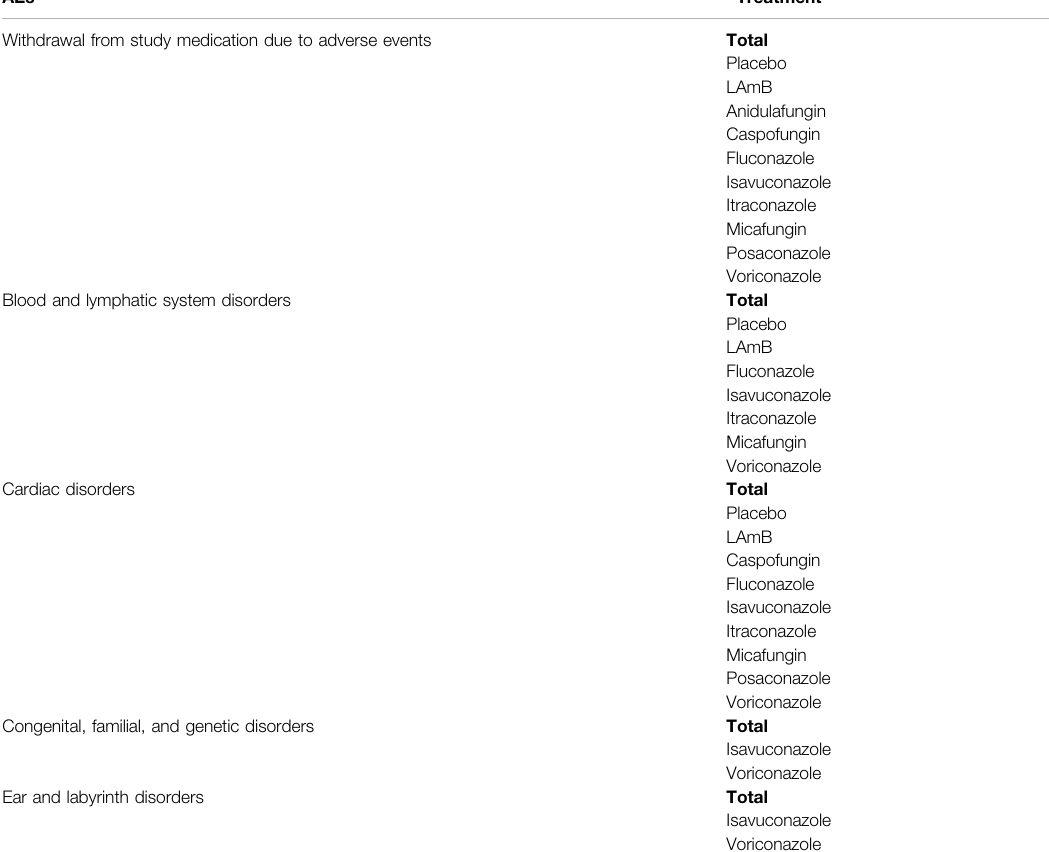
TABLE 1 | The antifungal agents involved in each AE, and the number of studies included in each AE. AEs Treatment Studies included Withdrawal from study medication due to adverse